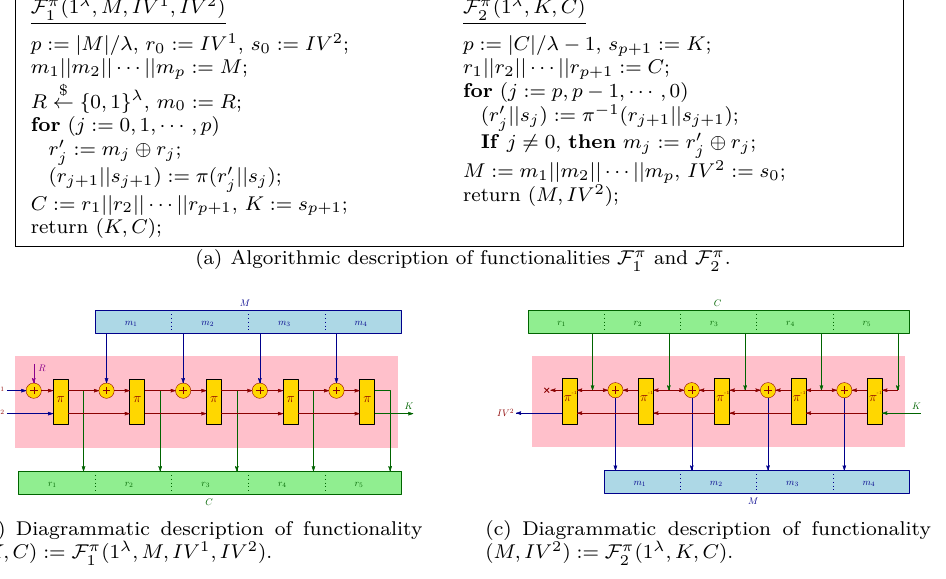
Figure 14: Algorithmic and diagrammatic descriptions of the functionalities F π